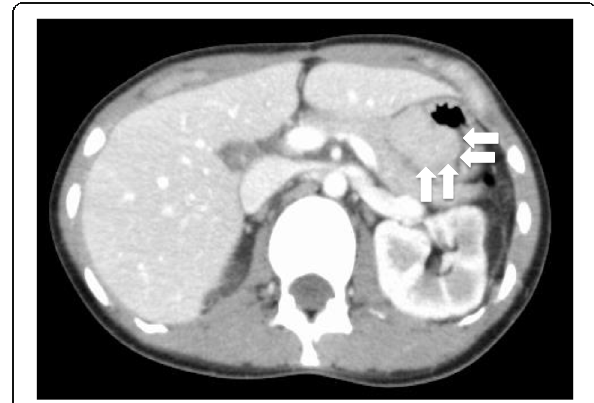
Fig. 5 Computer tomography image showing multiple